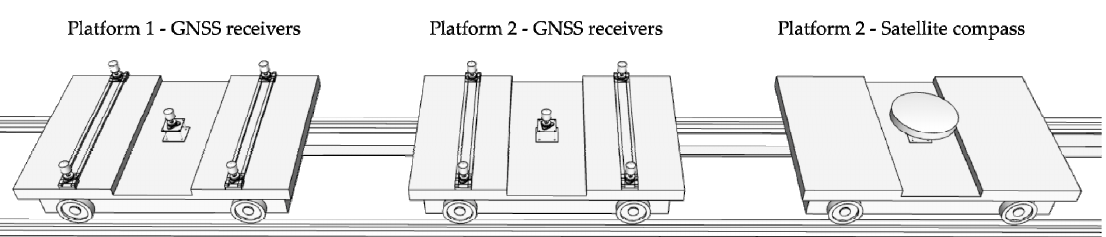
Figure 1. The measuring instruments used in satellite measurements at night on 28 November 2018–29 November 2018.